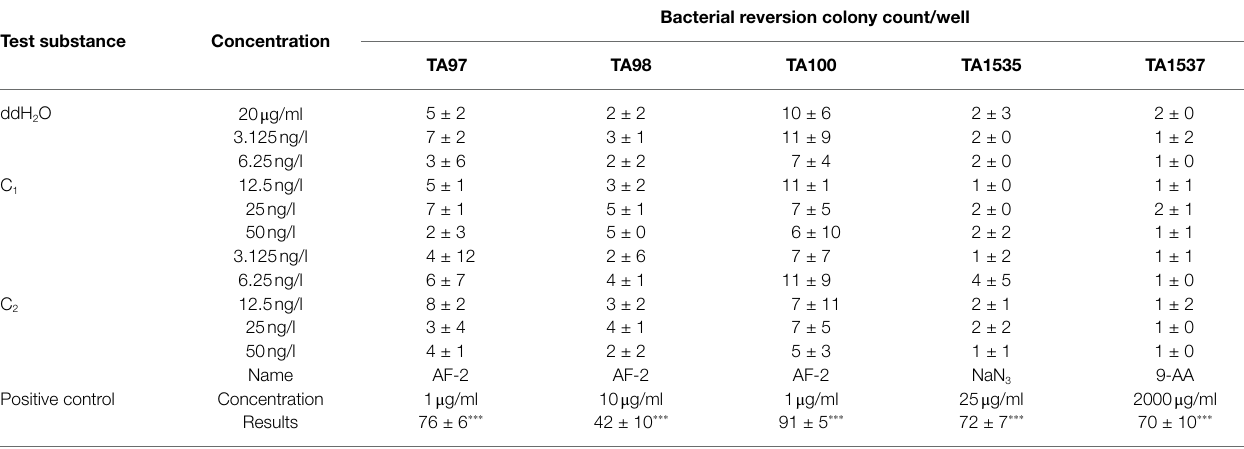
TABLE 8 | Results of 48 h bacterial reversion mutation under non-metabolic activation conditions (mean ± SD, n = 3).